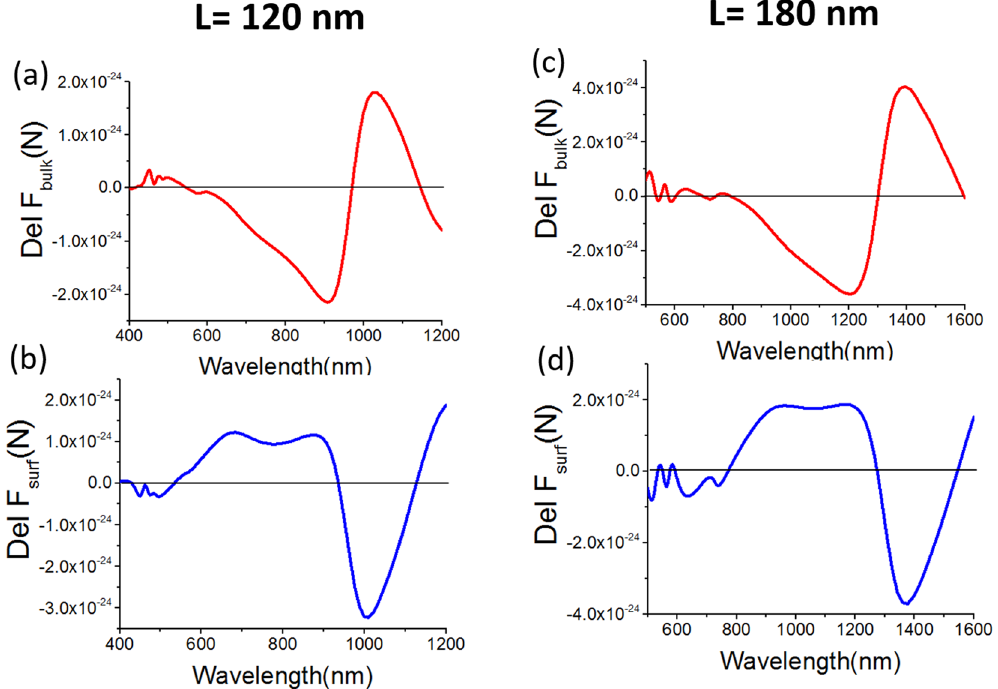
Figure 3. For cube homodimers over silver substrate, plot of Del F main text]. Spacer height is always 5 nm and height of the cubes from the spacer is fixed 5 nm from the spacer. For first column: Length of each cube is 120 nm and they are placed 100 nm apart. For second column: Length of each cube is 180 nm and they are placed 150 nm